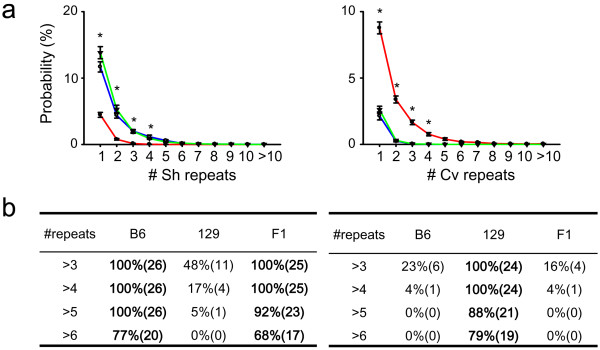
Sequential syllable structure for USVs of B6, 129, and F1 mice. (a) Syllable repetition in B6, 129, and F1 mice. The number of events of differing length was normalized with the total number of syllables. B6 and 129 mice emitted different amounts of short repetitions and chevron repetitions. B6-like phenotypes were dominant. * p < 0.01. (b) Proportions of animals with syllable repeats containing at three to six syllables.